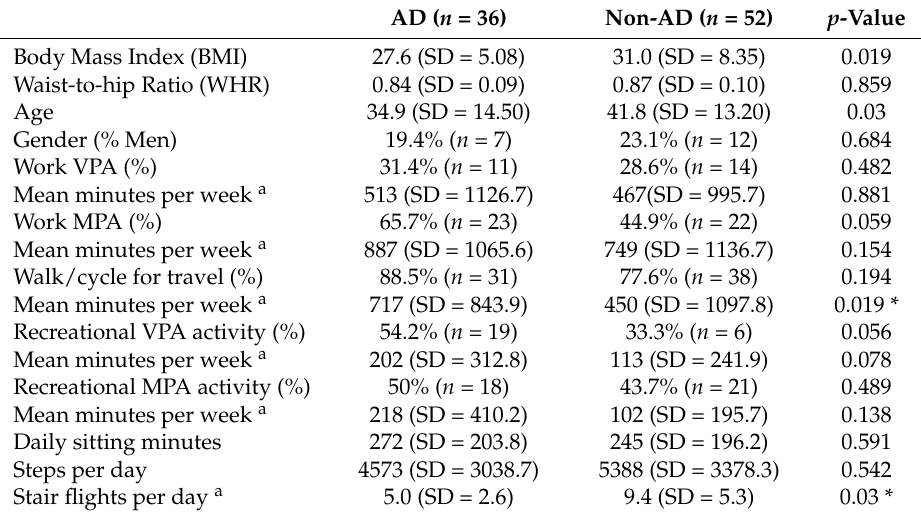
Table 1. Baseline (T0) Demographic Data and Physical Activity